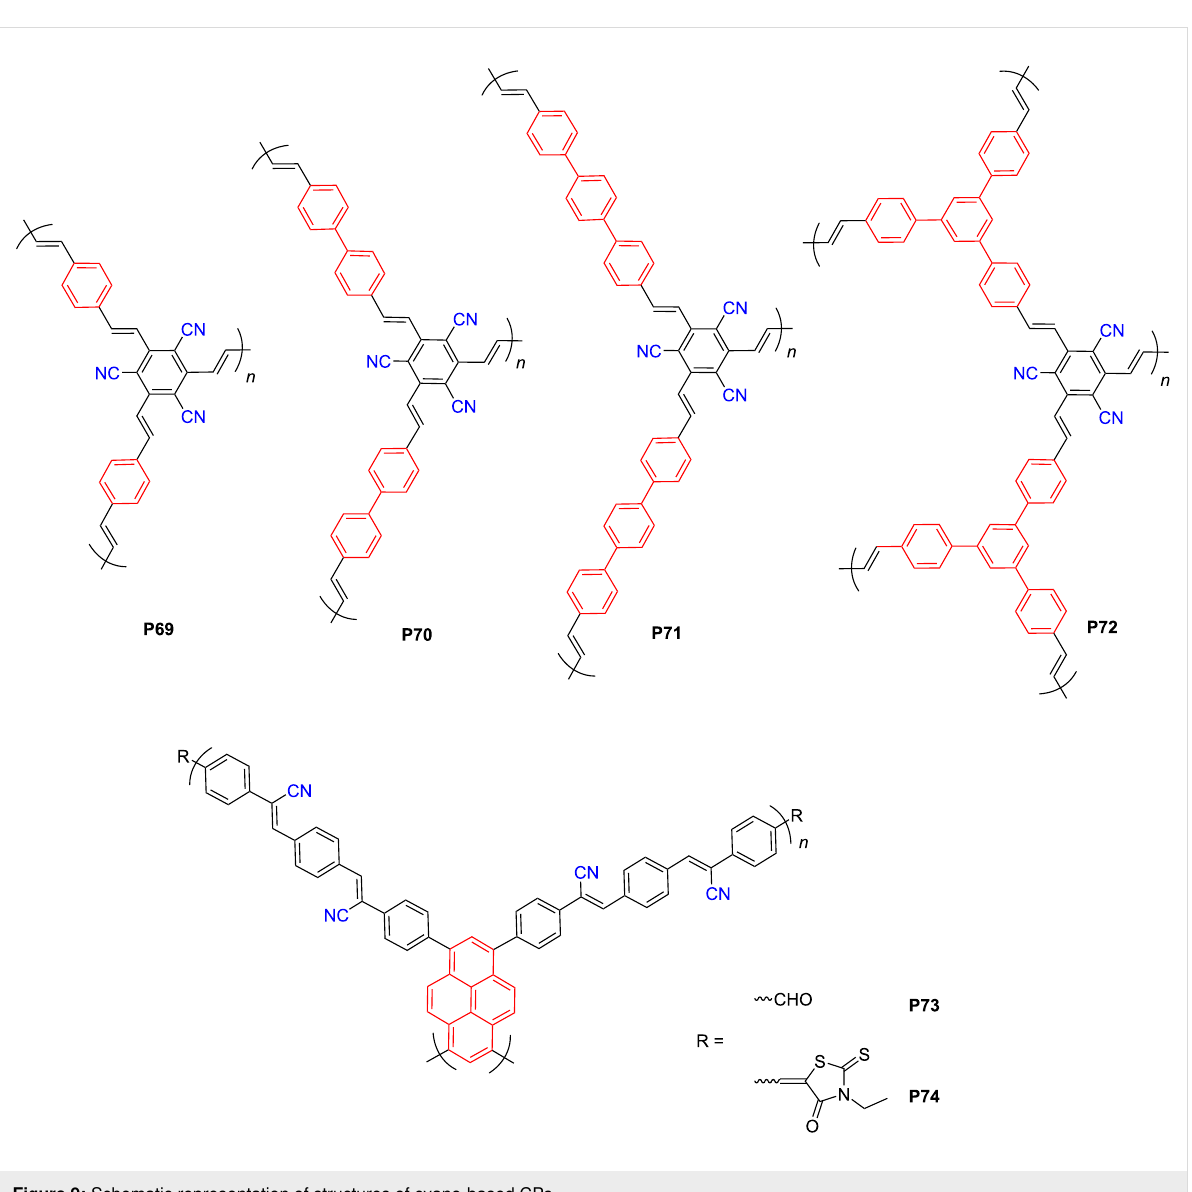
Figure 9: Schematic representation of structures of cyano-based CPs.